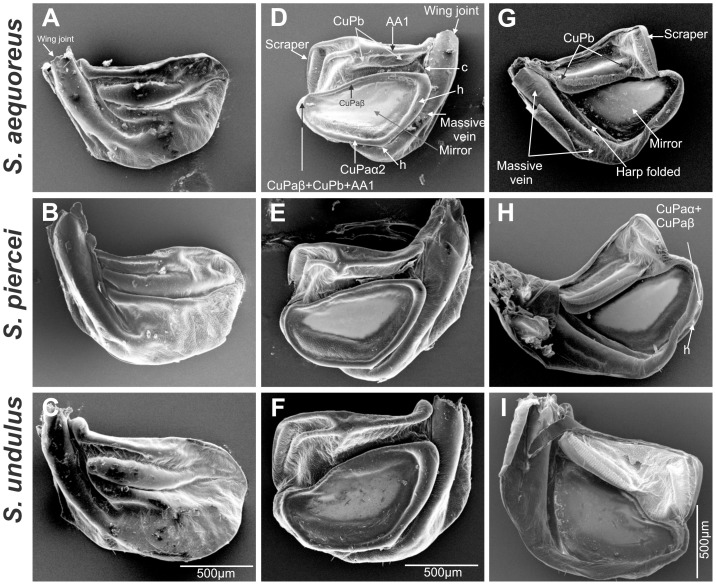
Male wing morphology comparison between Supersonus spp.(A–C). Left wing dorsal view. (D–F) Right wing dorsal view. (G–I) Right wing ventral view. First row of images: S. aequoreus, middle row: S. piercei, and third row: S. undulus.